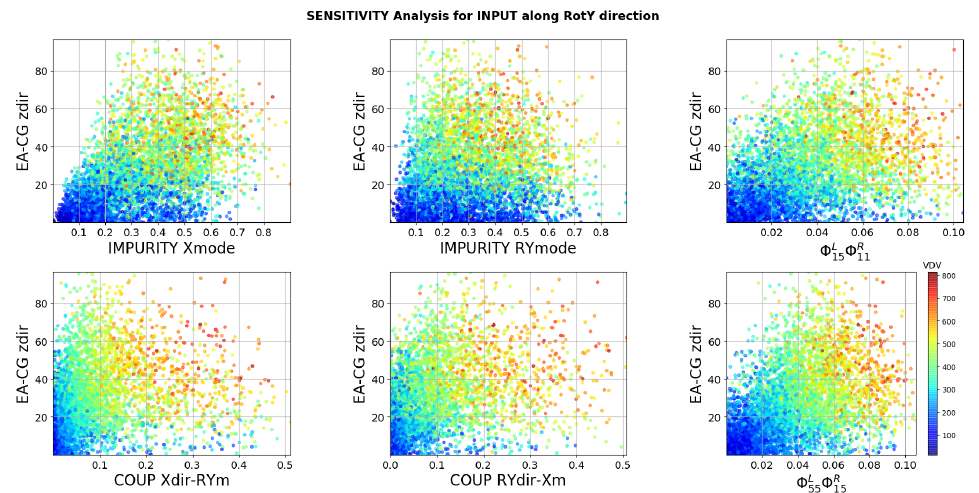
Figure 5. Scatterplots showing how the chosen modal quantities can be combined with the vertical distance of the elastic axis (EA) from the centre of gravity